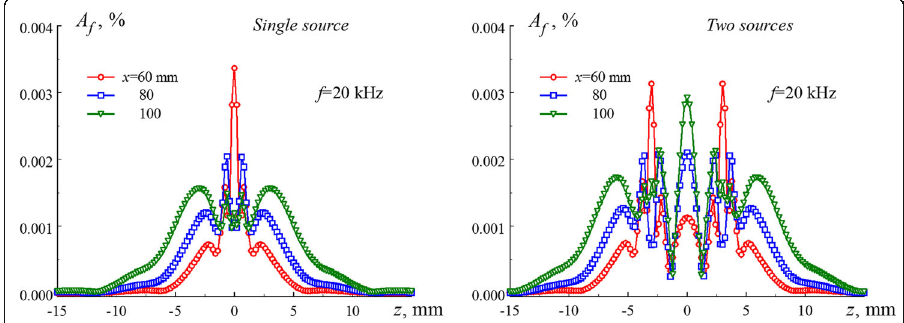
Fig. 5 Amplitude distributions of disturbances in the spanwise direction at f = 20